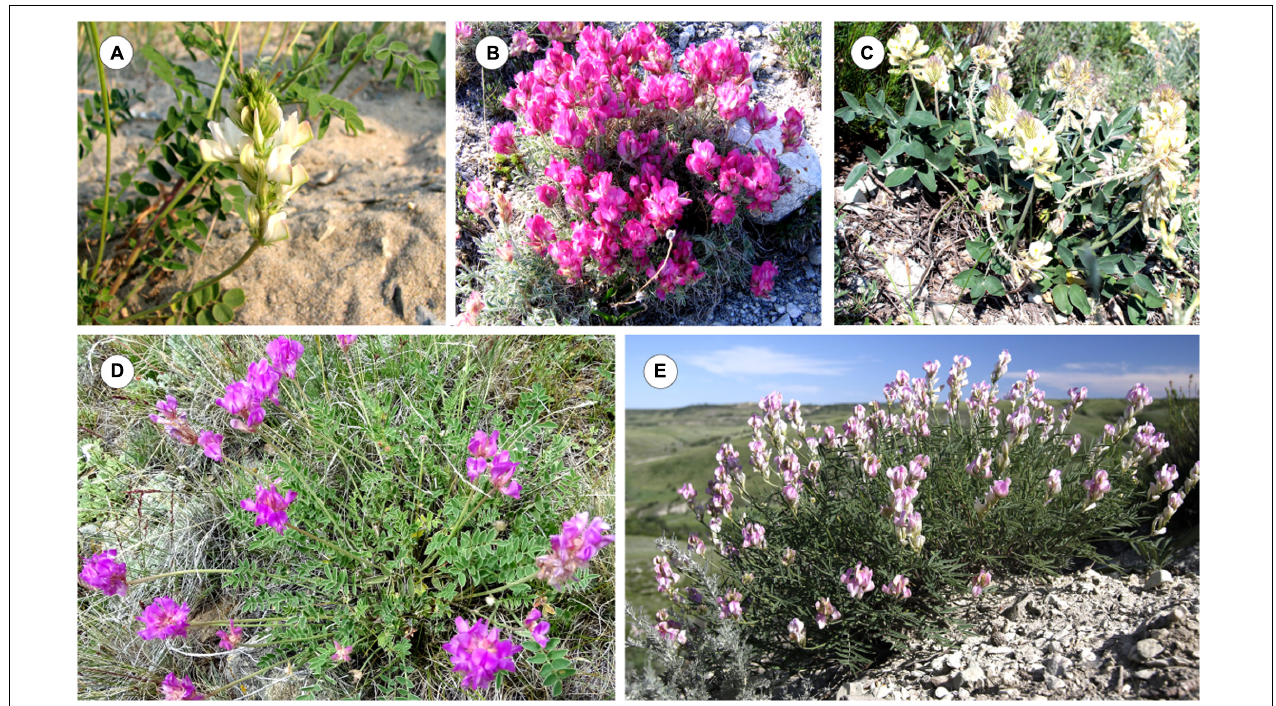
FIGURE 2 | Wild populations of H. dahuricum (Transbaikal territory, Russia) (A) , H. zundukii (Irkutsk region, Russia) (B) , H. grandiflorum (Volgograd region, RF) (C) , H. setigerum (Irkutsk region, Russia) (D) , and H. razoumovianum (Volgograd region, Russia) (E) . The images were taken by I. Yu. Selyutina (A,D) , S. G. Kazanovsky (B) , N. A. Suprun (C) , and A. V. Popov (E)